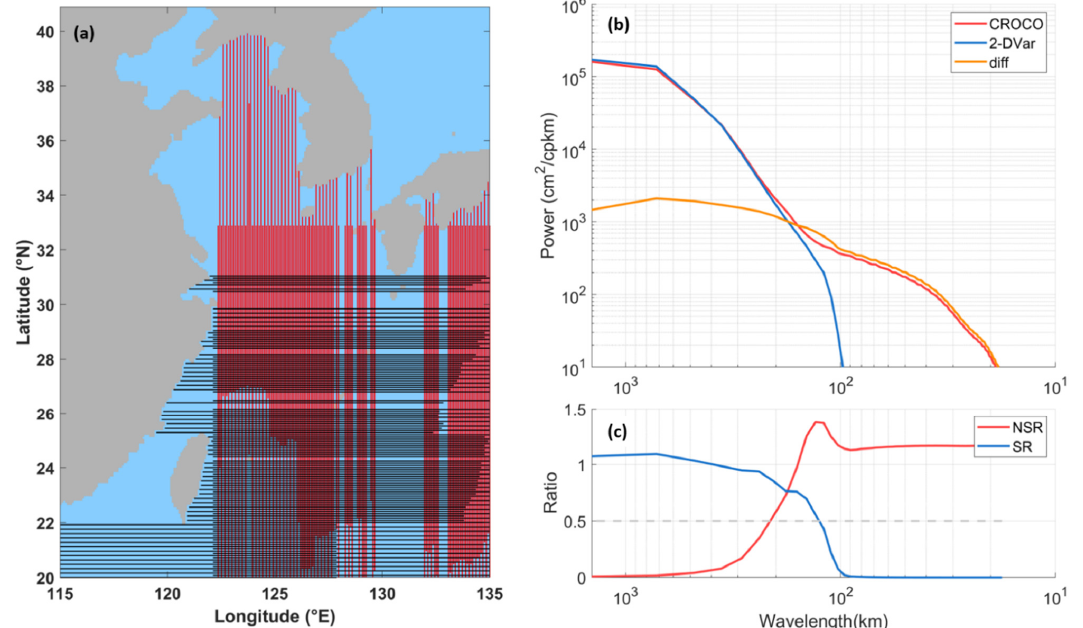
Figure 6. ( a ) Sampling locations of the spectral analyses, where the red and black lines represent the meridional and zonal sampling lines, respectively. ( b ) Averaged PSD from CROCO results (red line), OSSE 2-DVar (blue line) and their difference (orange line); ( c ) PSD ratio of OSSE 2-DVar to CROCO results (SR, blue line) and of their difference from CROCO results (NSR, red line).